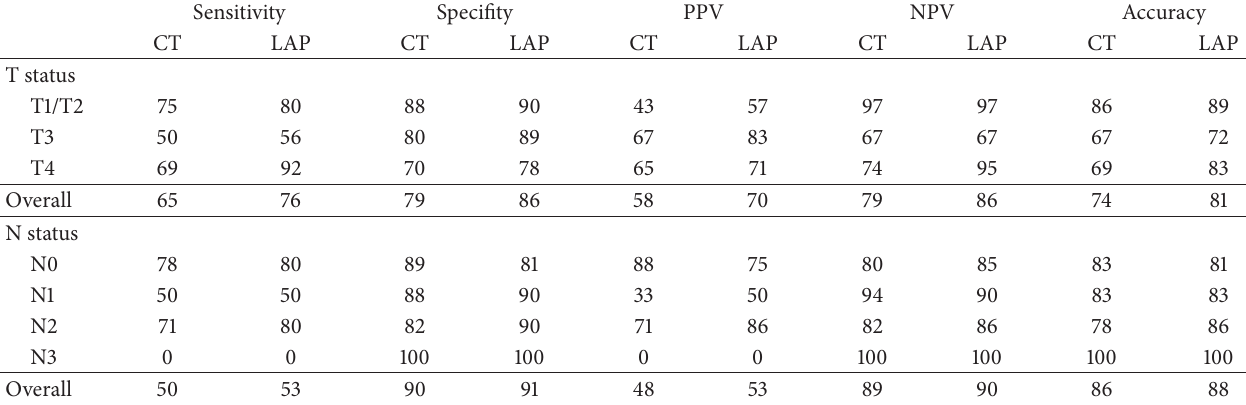
Table 3: Statistical analysis of CECT and laparoscopic vis-a-vis histopathologic T and N